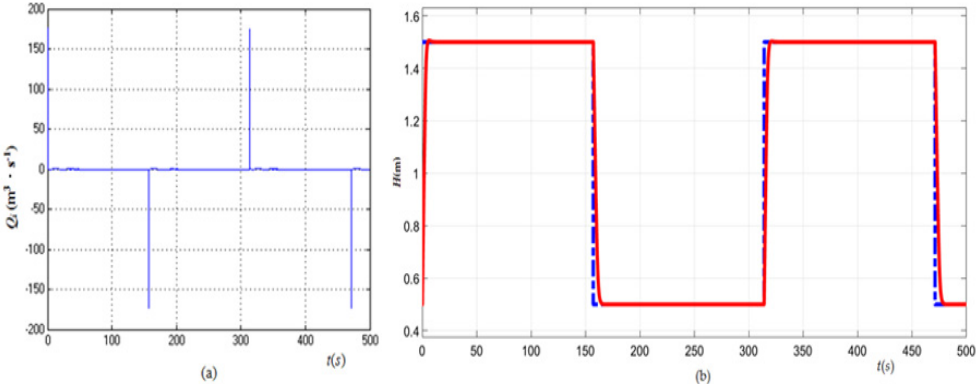
Figure 5. (a) and (b). Simulation results of nonlinear feedback of the modified PID controller. The inflow rate is 0.5 m 3 /s. (a) Curve of control input. (b) Curve of water level.